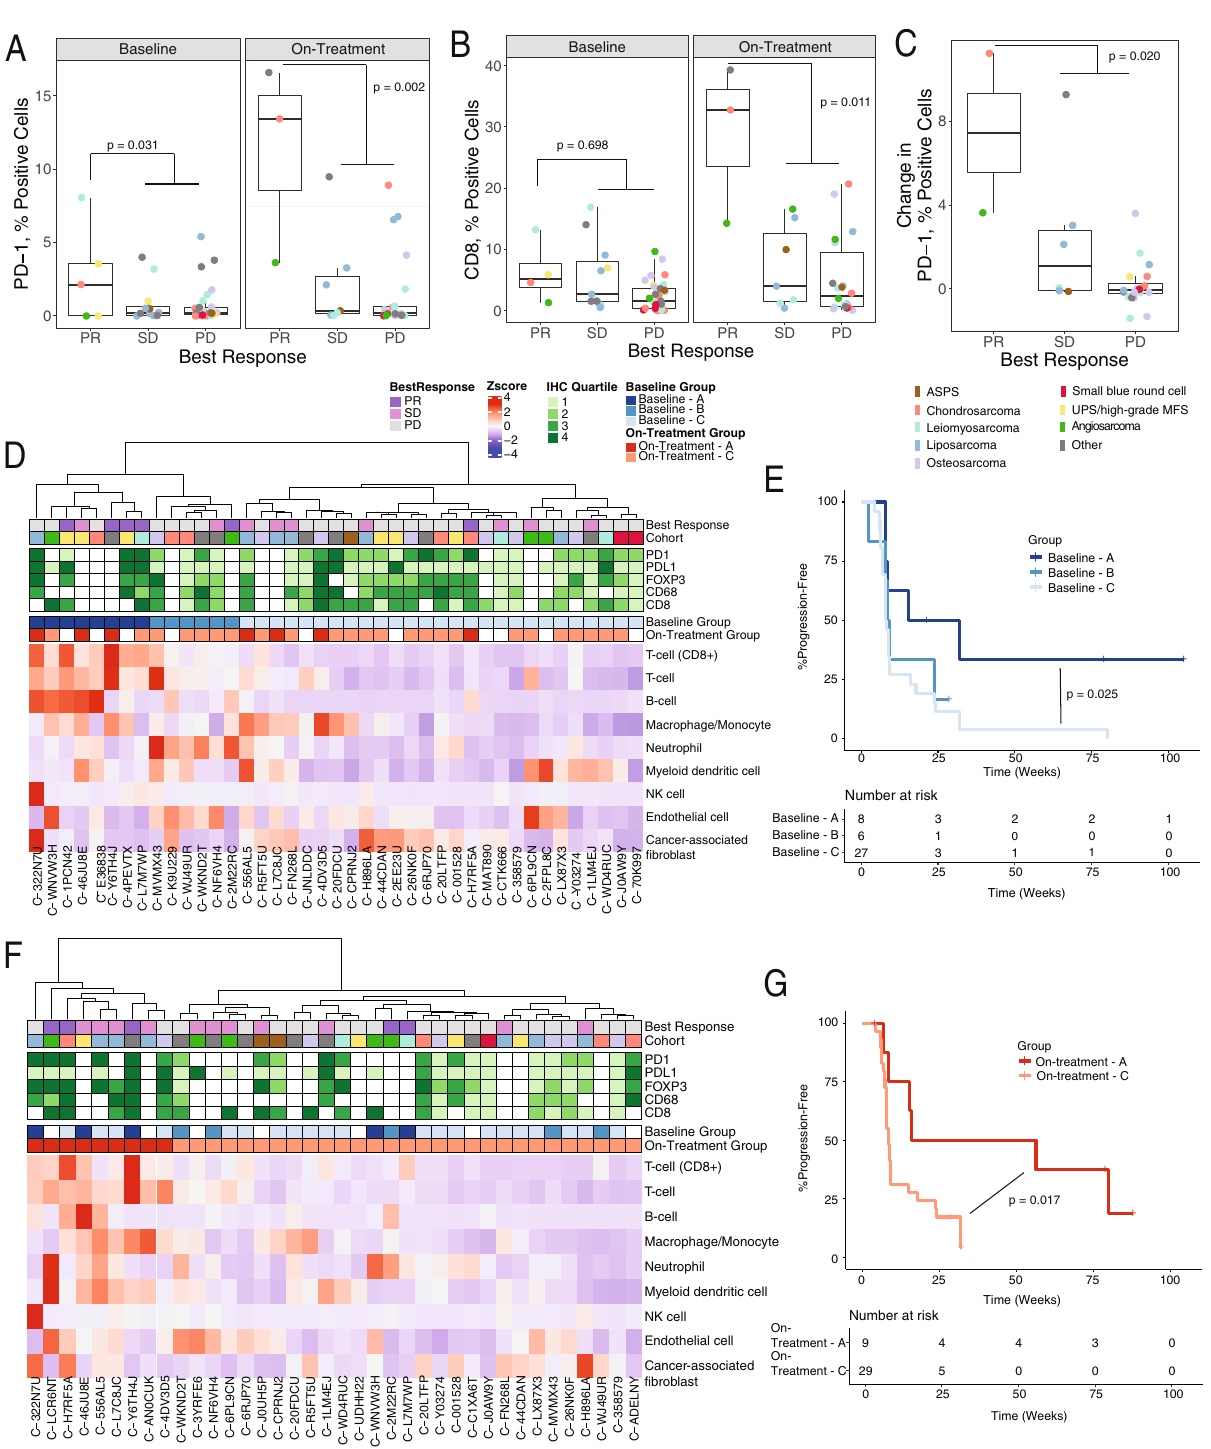
Fig. 2 Immune cell content in on-treatment samples differentiates response. A – C Percent ( A ) PD-1-positive cells (Baseline n = 5 patients [PR], 12 [SD], 31 [PD]; On-Treatment n = 3 [PR], 7 [SD], 23 [PD]), ( B ) CD8-positive T cells (Baseline n = 4 patients [PR], 11 [SD], 32 [PD]; On-Treatment n = 3 [PR], 7 [SD], 22 [PD]), ( C ) change in PD-1-positive cells ( n = 2 patients [PR], 6 [SD], 20 [PD]), as determined by IHC and categorized by best response and sample time point. A – C Colors indicate trial cohort. ASPS alveolar soft part sarcoma, UPS undifferentiated pleomorphic sarcoma, MFS myxo fi brosarcoma. P values are nominal and derived from linear model of positive cells with ORR including sarcoma subtype as a covariate. Boxplot shows the median with hinges at 25th and 75th percentile with whiskers extending to smallest or largest value, no more than 1.5 times interquartile range from the hinges. All values are shown with points. D , F Immune markers in baseline ( n = 41 patients) and on-treatment samples ( n = 38 patients), respectively, clustered using Manhattan distance and Ward D clustering on the immune populations from RNA-seq (bottom heatmap), with color coding for best response (top row), quartile of percent positive cells for 5 immune markers as detected using IHC, and immune clusters according to the dendrogram. E , G Kaplan – Meier plot of progression-free survival of 3 and 2 immune clusters de fi ned in D and F , respectively. Logrank p values shown for signi fi cant comparisons (Baseline n = 8 patients [A], 6 patients [B], n = 27 [C], On-Treatment n = 9 patients [A], On-Treatment n = 29 [C]). Source data are provided as a Source Data fi